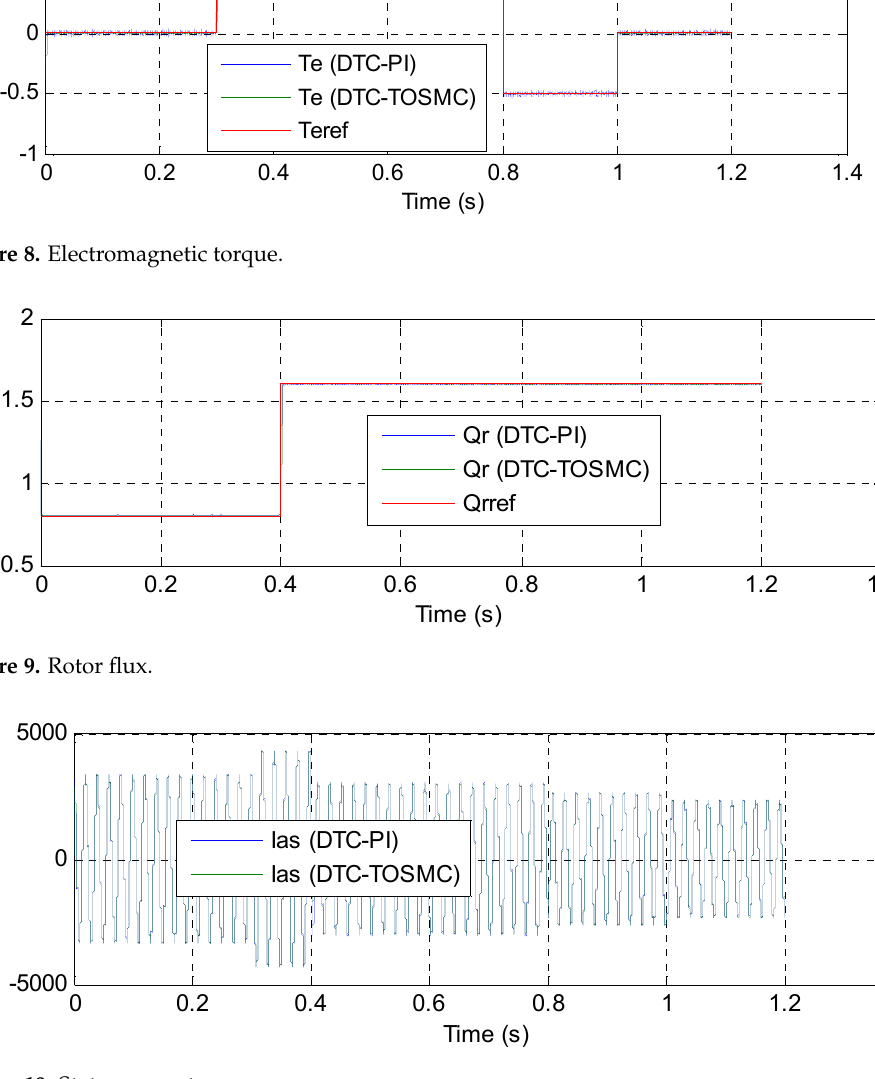
Figure 11. Zoom in the torque.